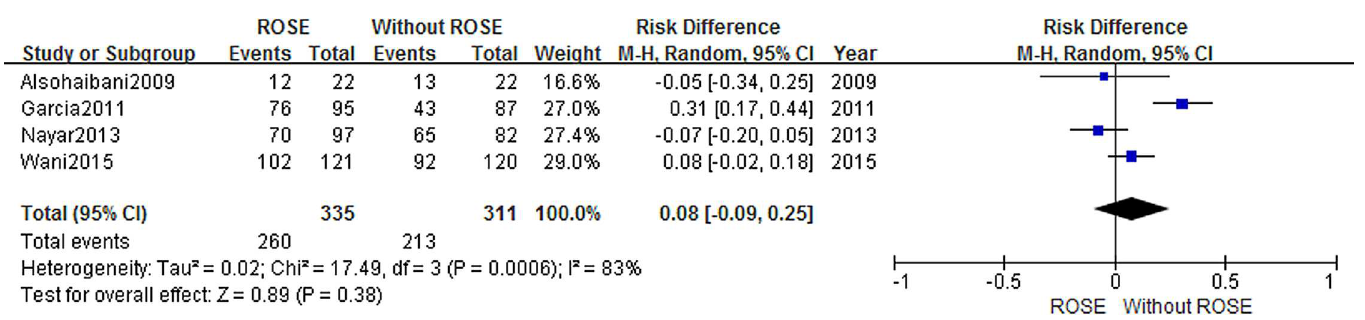
Fig 5. Forest plot displaying the Risk Difference and 95% CIs of each study for the diagnosis yield of malignancy.